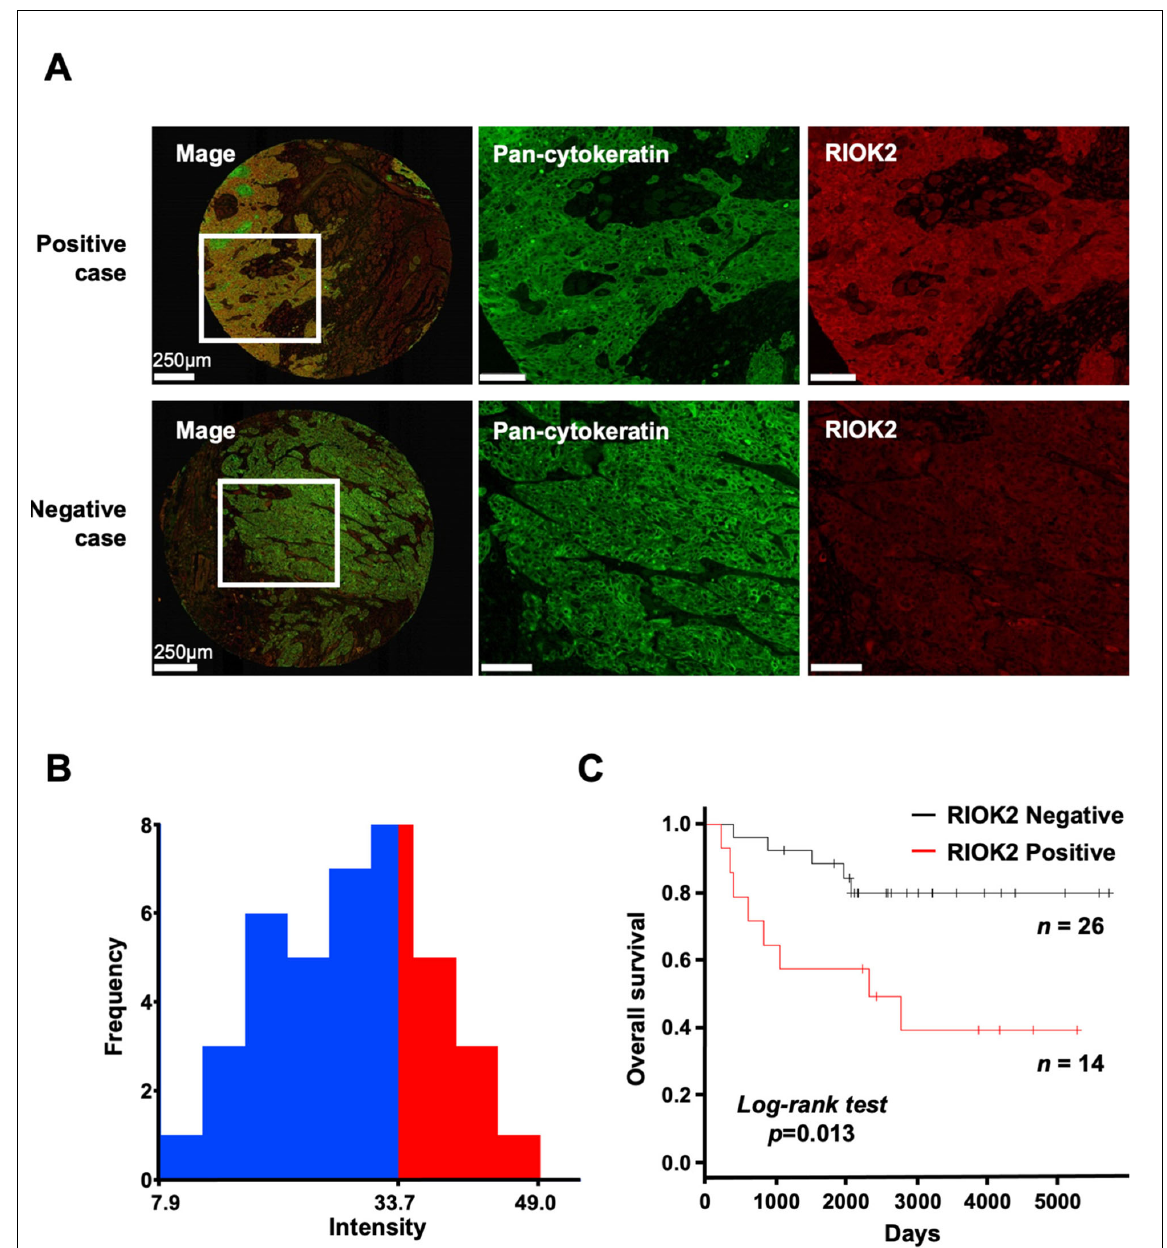
Figure 1. Relationship between RIOK2 expression and patient prognosis using 40 TSCC tissue samples. ( A ) Immunofluorescence staining with anti-pan-cytokeratin (green) antibody and anti-RIOK2 (red). Representative images of a positive case are shown in the upper panels and those of a negative case are shown in the lower panels. The scale bars indicate 250 µm in the whole images (left panel) and 100 µm in the middle and right panels. ( B ) Histogram shows the intensity of anti-RIOK2 fluo- rescence in individual patients, and the cut-off values for defining high-intensity (red) and low-intensity (blue) groups are shown. Differences were analyzed by log-rank test. ( C ) OS curves for the RIOK2-positive (red line, n = 14) and RIOK2-negative (black line, n = 26) subgroups ( p = 0.013).